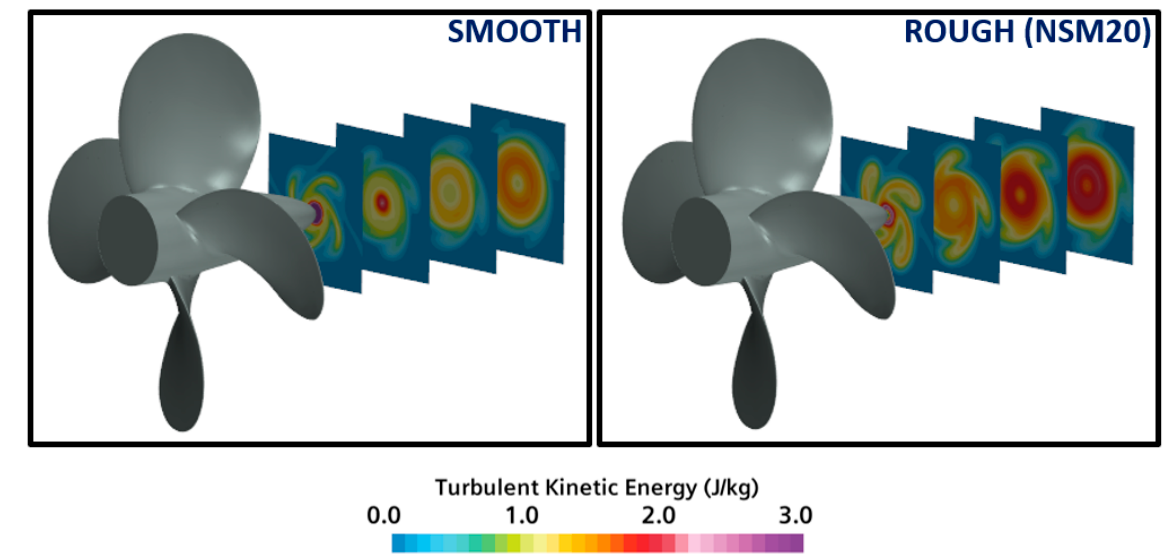
Figure 9. Change in turbulent kinetic energy with roughness.